Question: What style of plot is this figure drawn as?
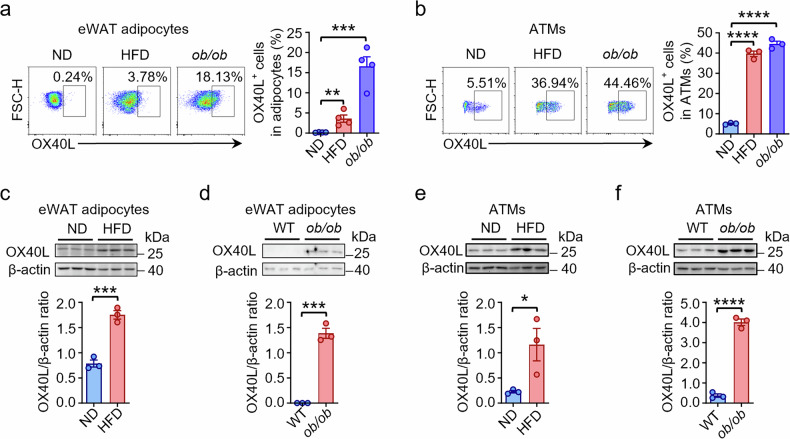
Answer: scatter